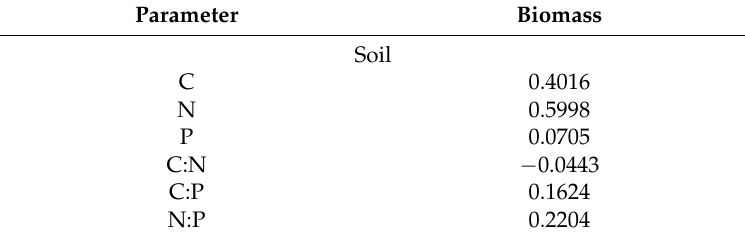
Table 6. Matrix of Pearson’s correlation coefficients of maize performance with soil and microbial